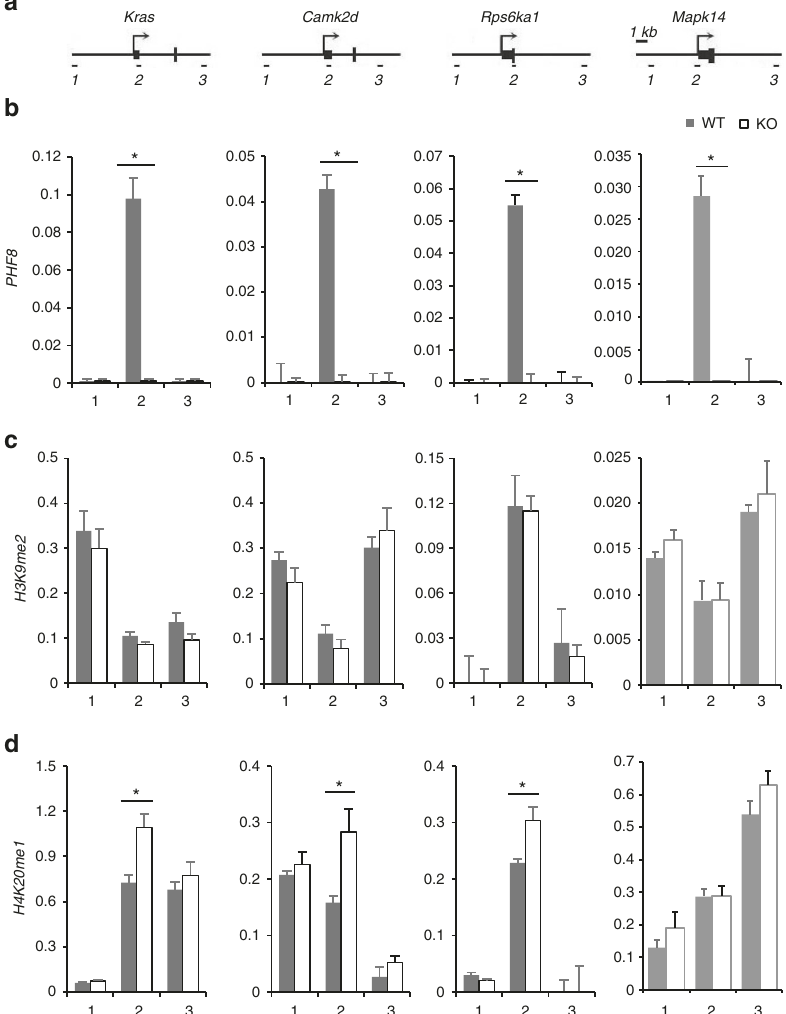
Fig. 4 Depletion of PHF8 increases the enrichment of H4K20me1 on overexpressed genes in Phf8 de fi cits. a Amplicons for real-time PCR are illustrated for three direct PHF8 target genes: Kras ; Camk2d ; Rps6ka1 ; and Mapk14 . The black arrow represents the transcription start site (TSS) of genes, small black squares indicate exon. Short lines below represent the locations of the amplicons by different primers. Scale bar = 1 kb; b Conventional CHIP analysis with PHF8 antibody shows the speci fi c binding of PHF8 on TSS loci of its targeting genes. c The enrichment of H3K9me2 on the PHF8 target genes is not changed by deletion of Phf8 . d The enrichment of H4K20me1 on the overexpressed Kras , Camk2d , and Rps6ka1 were enhanced by deletion of Phf8 , while the enrichment of H4K20me1 was not changed in the TSS of Mapk14 . Real-time PCR was performed on the input and immunoprecipitated genomic fragments. Data are presented as percentage of input. Numbers on the x axes represent the different amplicons. All data are shown as mean ± s.e.m. * p < 0.05; ** p < 0.01 and *** p <